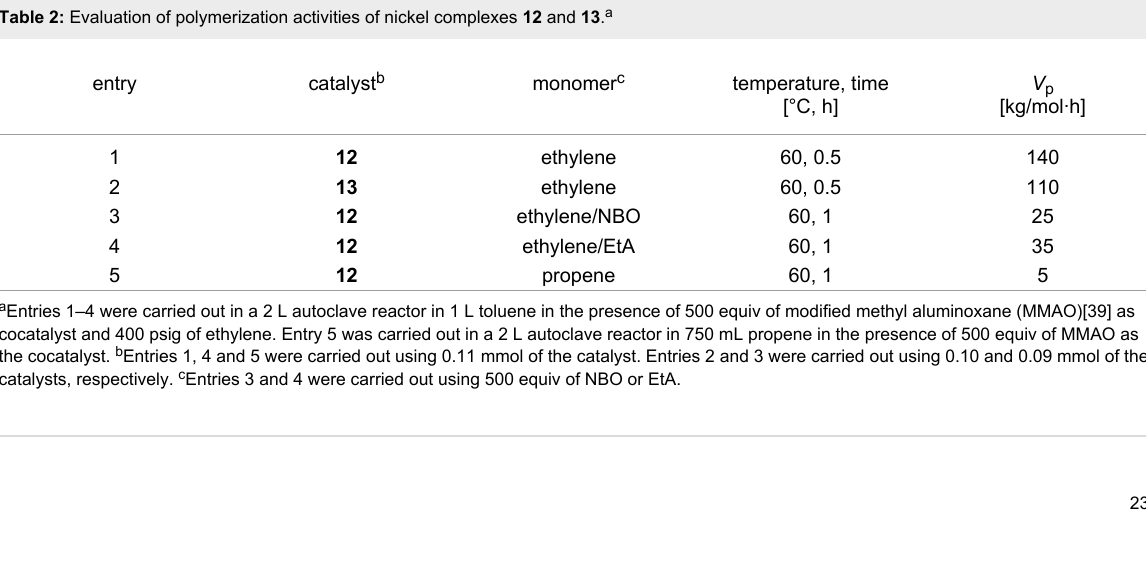
Table 2: Evaluation of polymerization activities of nickel complexes 12 and 13 . a